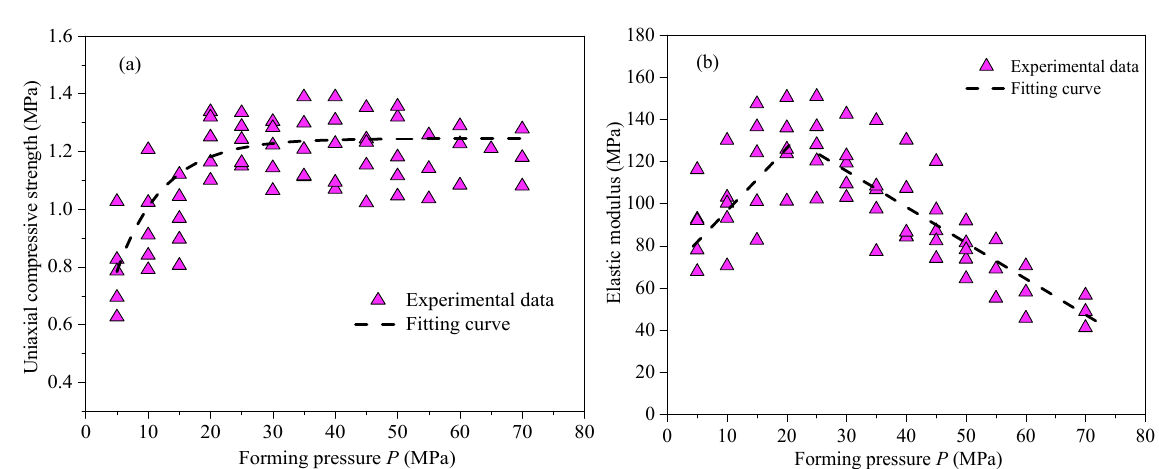
Figure 9. Relationship between mechanical parameters and forming pressure of RTC. ( a ) Uniaxial compressive strength; ( b ) elastic modulus.